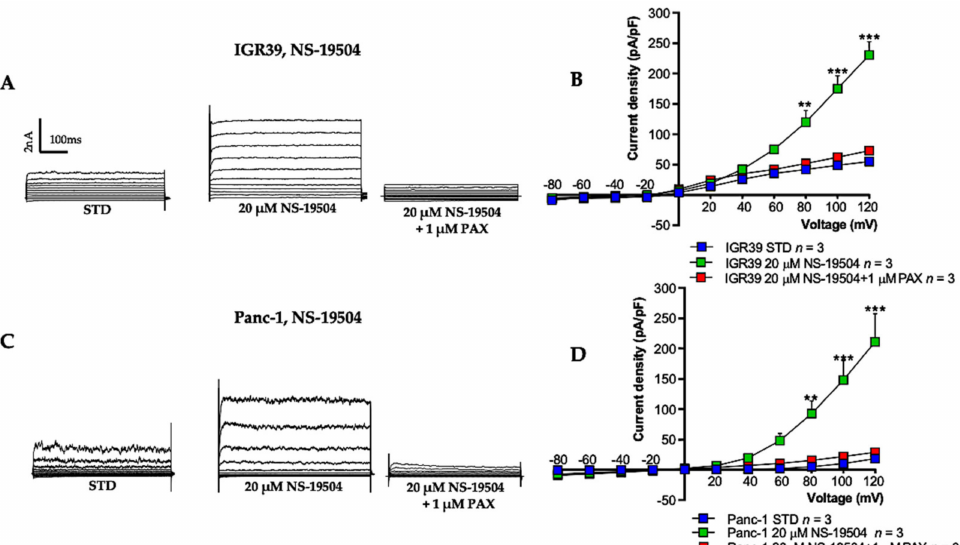
Figure 3. Effect of NS-19504 on membrane current in IGR39 and Panc-1 cells. Representative current traces obtained before and after NS-19504 addition, and after additional application of 1 µ M paxilline in cells stimulated with voltage increments of +20 mV from − 80 to +120 mV applied from a holding potential of − 50 mV in ( A ) IGR39 and in ( C ) Panc-1. The duration of the voltage steps was 500 ms. Current density-to-voltage relationship measured in whole-cell patch-clamp experiments ( B ) in IGR39 and ( D ) in Panc-1. ** p < 0.01 and *** p < 0.001 versus STD condition, as determined by paired Student’s t -test. (n) refers to the number of